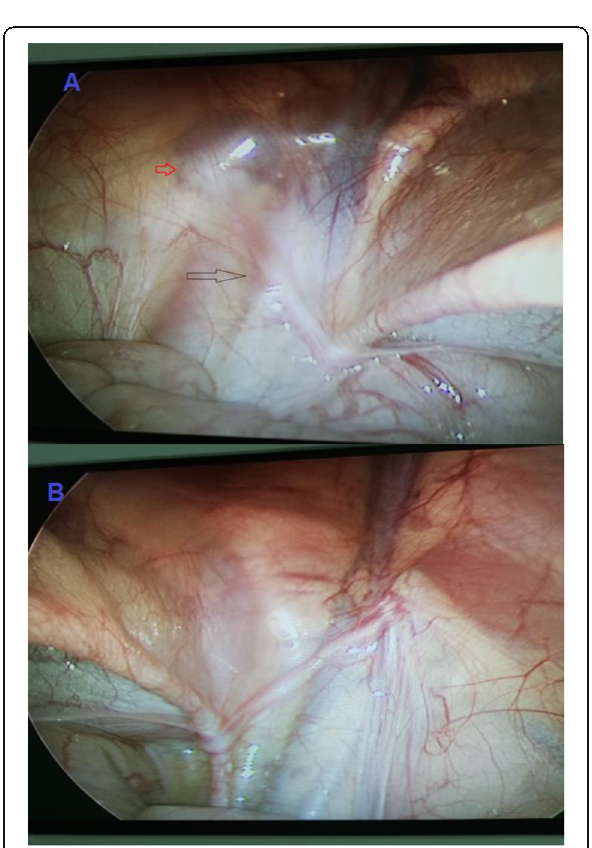
Fig. 10 a Vanished proximal portion of the left vas deferens with absent vessels (black arrow), left closed internal ring (red arrow). b Right side with normal vas deferens and vessels for comparison